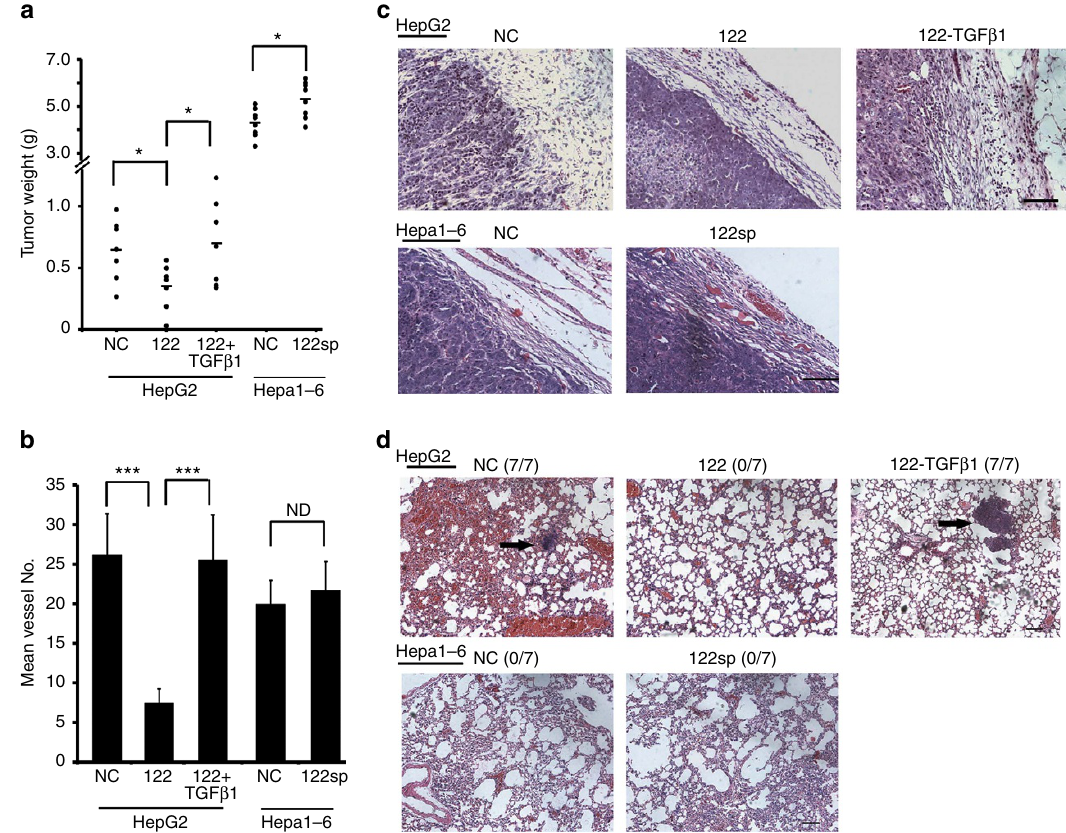
Figure 5 | Switch of miR-122 targeting from TGF b R1 to TGF b 1 generates different metastatic effects in human xenografts or mouse allografts. ( a ) Tumour volume was measured after 5 weeks when the indicated cells expressing individual miRNAs or the control hairpin (negative control, NC) cells were subcutaneously implanted into immunodeficient mice. Seven independent repeats are performed in each experiment. ( b ) Quantitative analysis of the vessel numbers in the indicated tissues. Seven independent repeats are performed in each experiment. ( c ) Haematoxylin and eosin (H&E) stain of primary tumours 60 days after subcutaneous injection. Mice were subcutaneously implanted with HepG2 cells stably expressing NC, miR-122 or both miR-122 and TGF b 1 (122-TGF b 1), or with Hepa1-6 cells stably expressing NC or miR-122 sponge (122sp) in each group. Seven independent repeats are performed in each experiment. Scale bar, 50 m m. ( d ) H&E stain of lungs isolated from mice that received tail vein injection of the indicated cells. Seven independent repeats are performed in each experiment. Scale bar, 50 m m. Error bars, ± s.d. * P o 0.05; *** P o 0.001 by two-sided Student’s t -test. ND, no